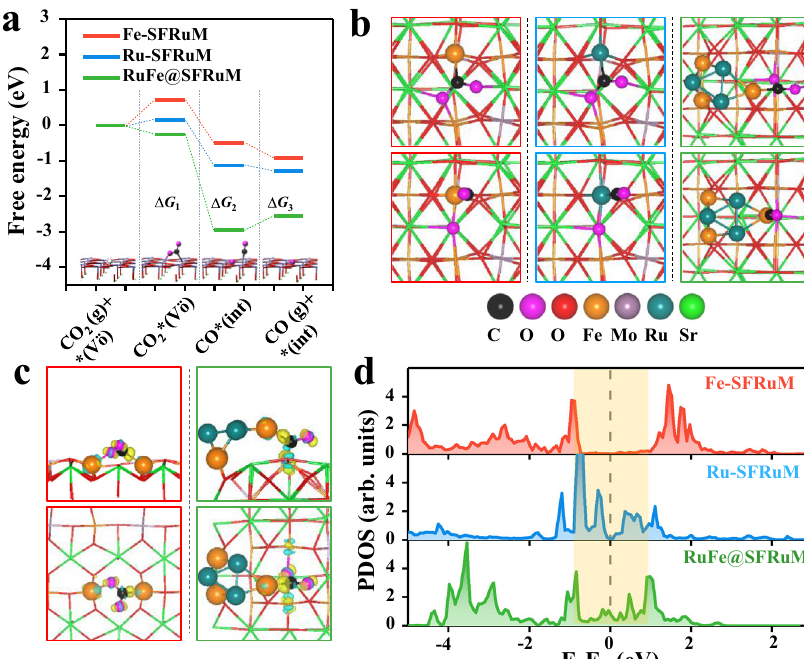
Fig. 6 DFT-based energetic and electronic structure analysis of CO 2 electrolysis. a Gibbs free energy diagram for CO 2 electrolysis over three active sites: Fe and Ru centers at SFRuM (121) surface and Fe border at RuFe@SFRuM interface (800 °C and − 1.0 V). *(V (cid:1) the intact surfaces. b Corresponding local atomic con fi gurations (top view) from CO 2 * (upper) to CO* (lower). c Top (upper) and side (lower) views of electron density differences of CO 2 adsorption over Fe-SFRuM surface and RuFe@SFRuM interface. Yellow and cyan areas denote the accumulation and dissipation of electrons. d PDOS of active Fe and Ru centers at SFRuM surface and RuFe@SFRuM interface before CO 2 adsorption. The dashed gray line marks the Fermi level and the orange block highlights the main difference of the d